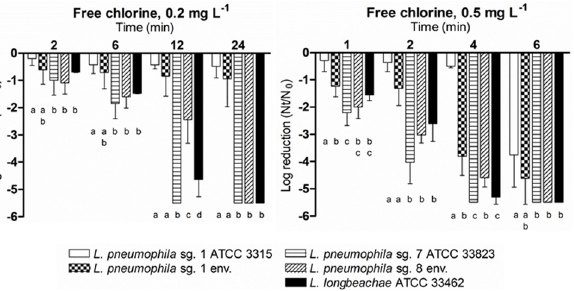
Fig 1. Effect of free chlorine 0.2 mg L -1 and 0.5 mg L -1 , on the inactivation of 5 Legionella strains. Bacterial inactivation was determined using viable counts on BCYE agar medium. Data are presented as means ± SD (columns and error bars; n = 3). Statistical differences between means within each time point were represented assigning different letters to the bar plot. The same letter was assigned to bars with no significant differences between them. Statistical analyses were performed by ANOVA and pairwise Fisher ’ s LSD test ( p < 0.05).